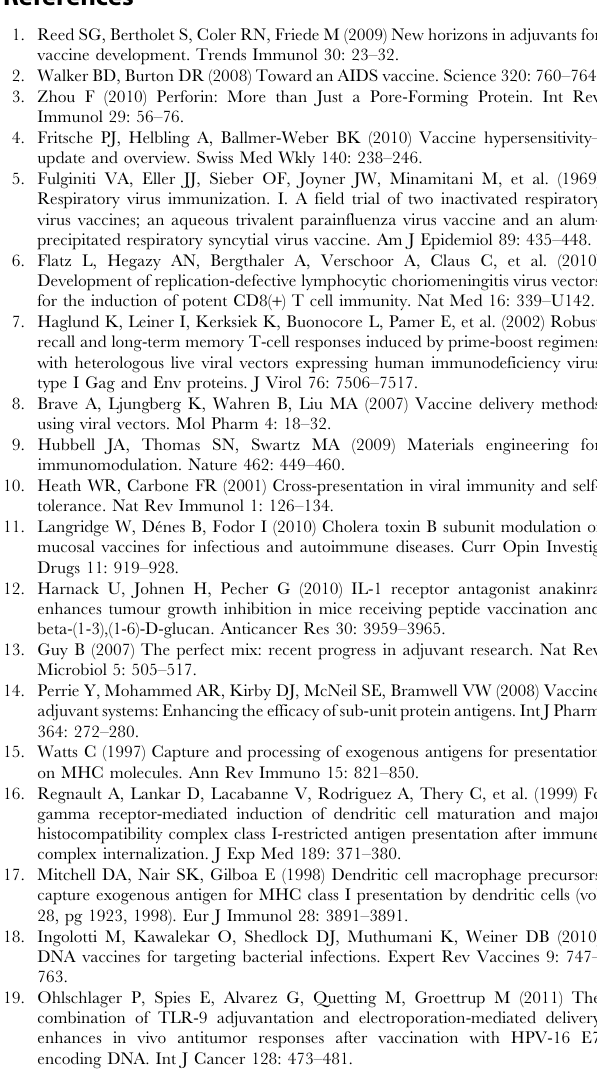
Figure S1 Flow cytometry gating scheme used to define cell populations. (A) A representative dotplot from a CPZ-OVA immunized mouse was gated on lymphocytes using SSC versus FSC. The percent of CD3 + CD8 + memory T cells was determined from the events in the lymphocyte gate. (B) The lymphocyte gated population was further gated on CD3 + T cells and CD3 + T cells were separated into CD8 + or CD4 + T cells. Memory